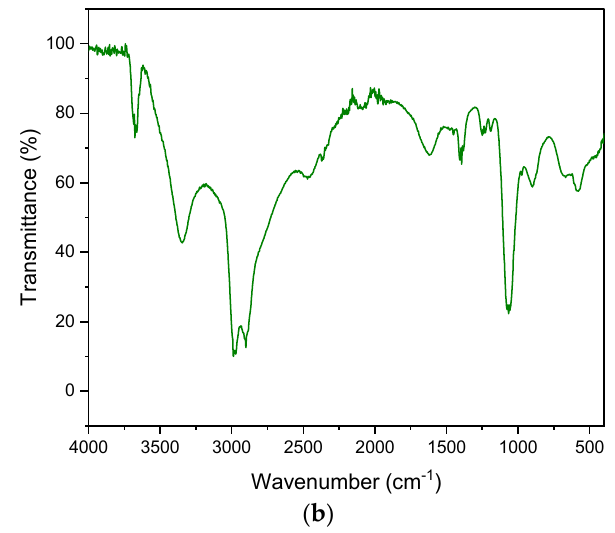
Figure 6. FT-IR spectrum. ( a ) diatomite; ( b ) aluminium potassium alum.